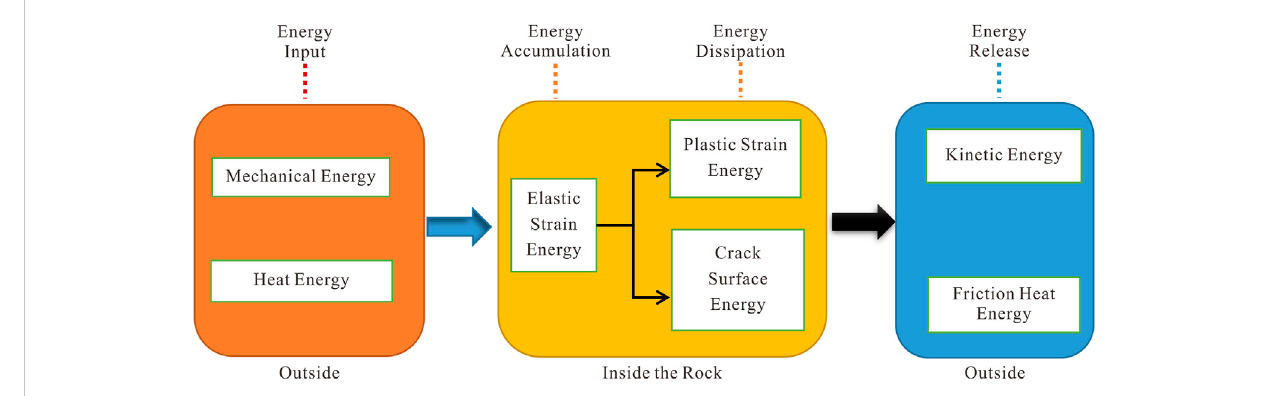
FIGURE 1 Energy transformation of rock under external load.